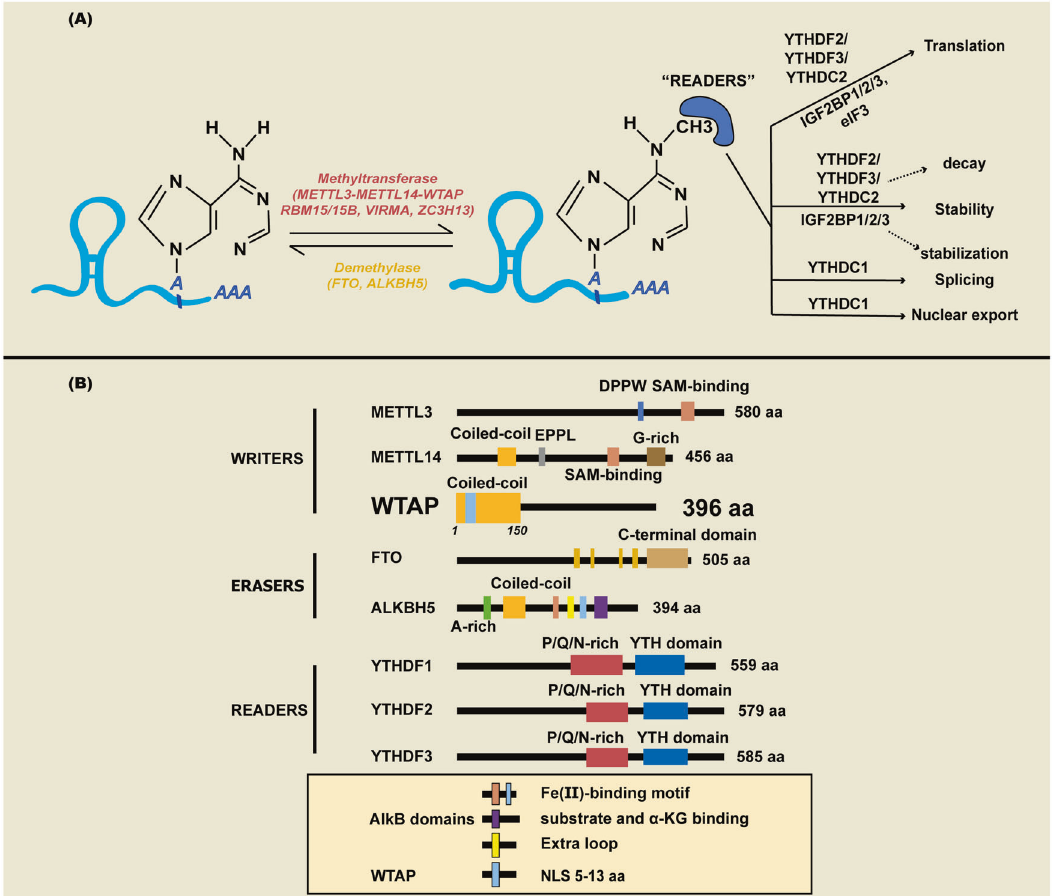
Fig. 1 Mechanism of m6A and fuctional domais in m 6 A methyltransferase. A The dynamic molecular mechanism of m 6 A modi fi cation. m 6 A is installed by “ writers ” (METTL3/14, WTAP, RBM15/15B, VIRMA, and ZC3H13), removed by “ erasers ” (FTO, ALKBH5, and ALKBH3), and recognized by “ readers ” (YTHDC1/2, YTHDF1/2/3, IGF2BP1/2/3, HNRNP, and eIF3). B Functional domains in m 6 A writer, eraser, and reader